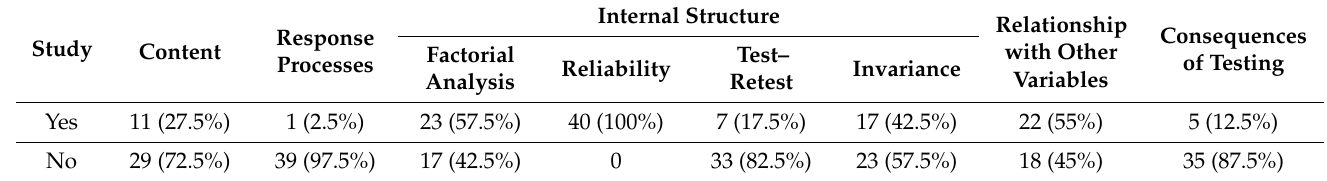
Table 2. Number of studies and percentages for each validity